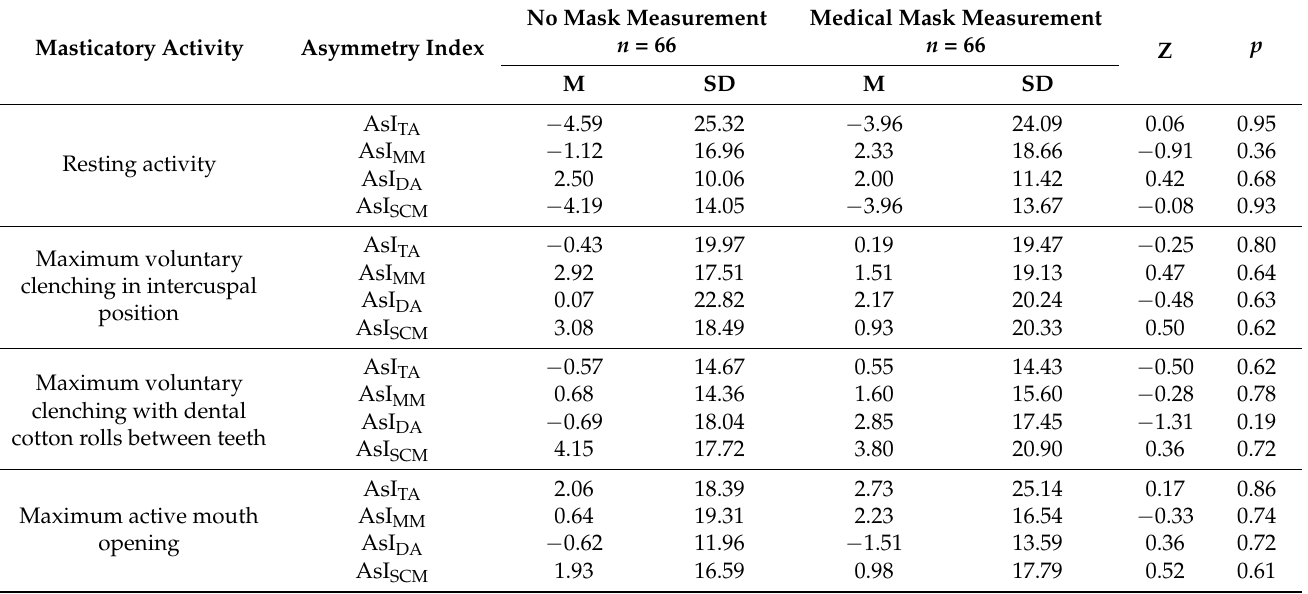
Table 2. The comparison of the mean asymmetry index (AsI) between no mask and medical mask measurements.